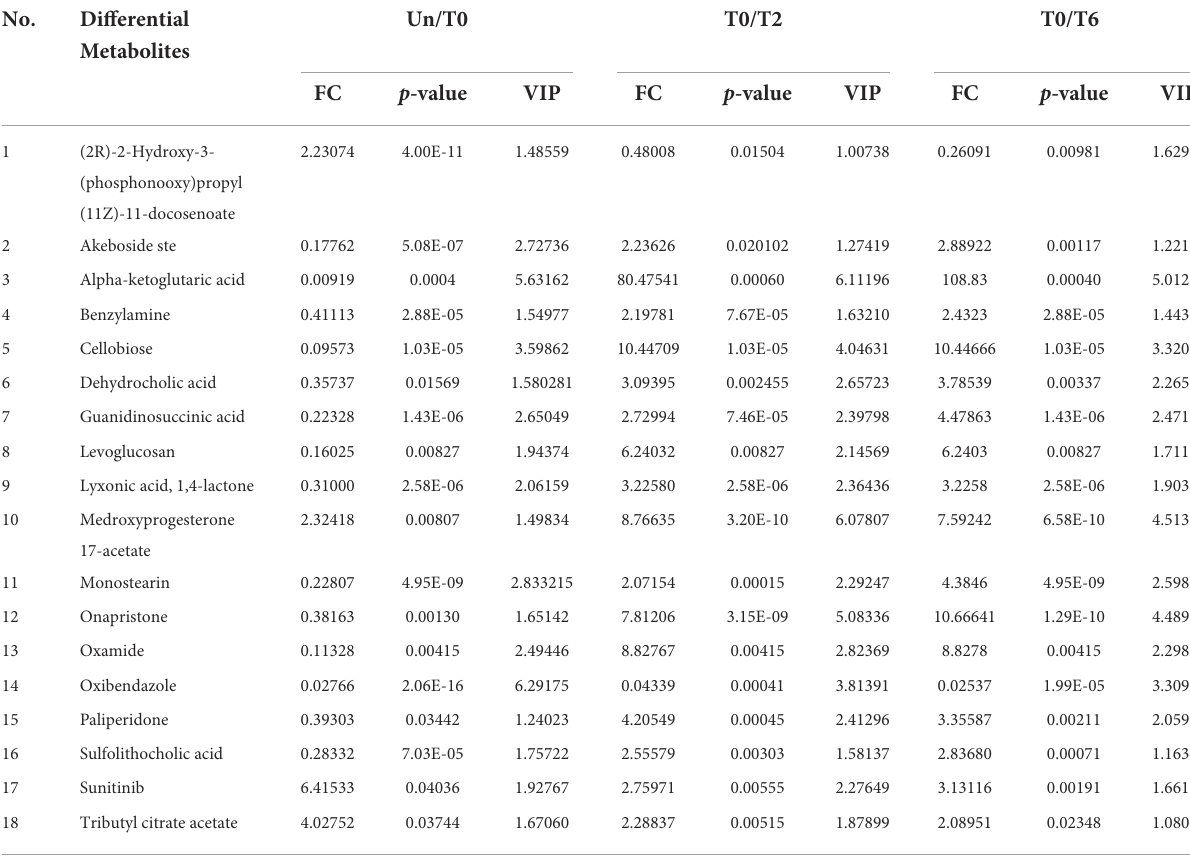
TABLE 3 Metabolites with significant changes in the relative amount identified by LC-MS/MS and GC-MS among the Un group, T0 group, T2 group, and T6